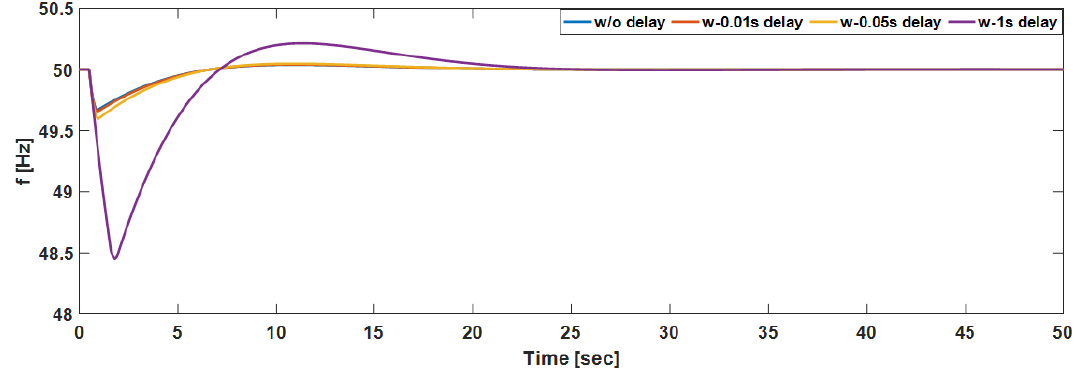
Figure 11. Frequency behavior due to time